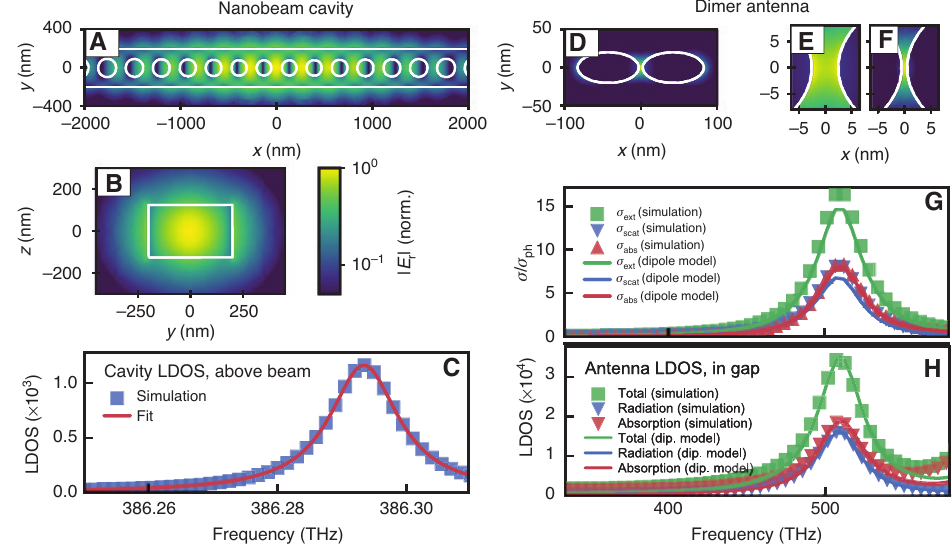
Figure 2: Properties of the separate components of the nanobeam cavity and the dimer antenna. (A) x , y crosscut of the cavity design and of the field distribution in the cavity. We see that the field is confined in the central defect of the photonic crystal. (B) y , z crosscut in the center of the nanobeam cavity, showing that most of the field is centered in the high-index Si (C) The LDOS of the cavity system at 25 nm above the beam. It has a maximum value of 1.16 × 10 3 and a width of 0.013 THz, which gives a Q of 3.0 × 10 4 . (D) A crosscut of the plasmonic antenna. Clearly, most of the field is concentrated in the 5 nm gap between the metal particles. (E, F) Magnified images of the field profiles of the antennas with a gap separation of 5 and 1 nm, respectively. Note that all field profiles in (A, B) and (D–F) are normalized to their maxima and shown on a logarithmic scale. (G) Extinction, scattering and absorption cross-sections σ , σ and σ , respectively, of an antenna with L = 80 nm and a gap of 5 nm, showing the increase of cross-sections at resonance. Cross- ext scat abs sections are normalized to the physical cross-section σ . We compare values obtained directly from simulations and indirectly via a dipole ph model, showing good agreement. (H) The LDOS in the center of the antenna gap (same antenna as in (G)). It shows a peak at the dipolar resonance. Again, we find good agreement between our dipole model and the numerical simulations. Deviation at the highest frequencies is due to the onset of a multipolar